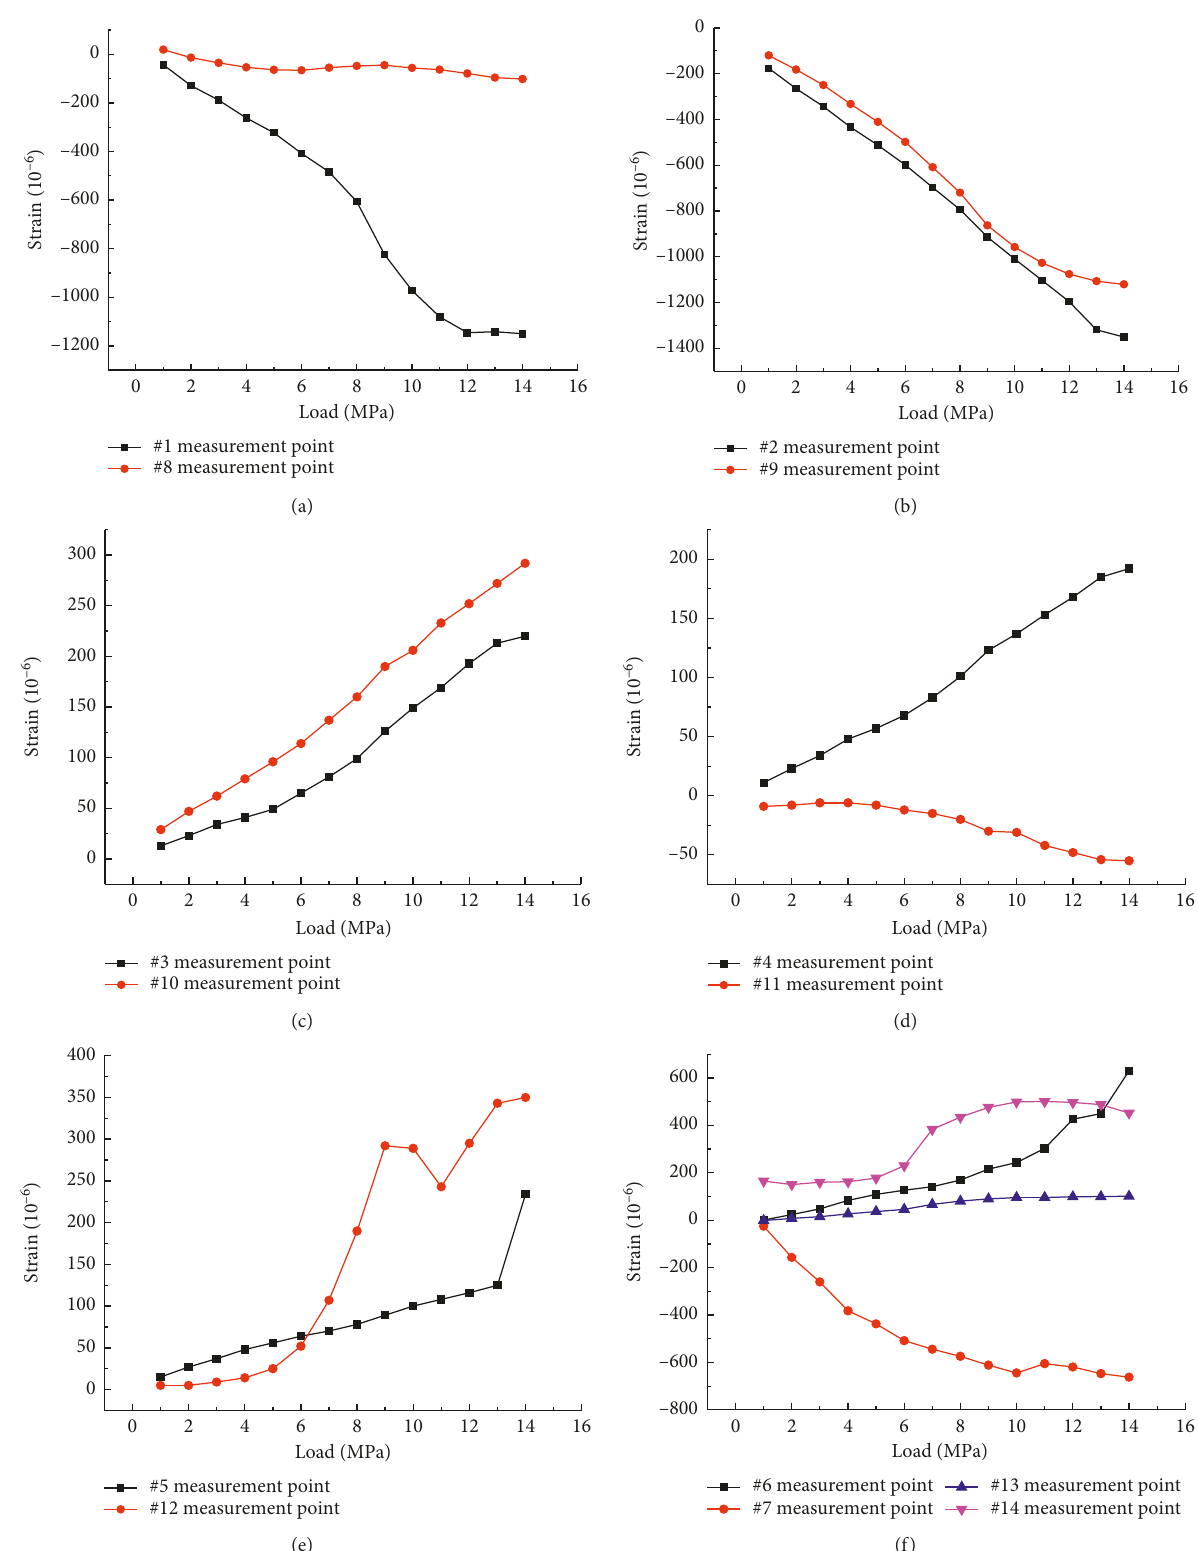
Figure 12: Strain-load curve of the model. (a) Group 1. (b) Group 2. (c) Group 3. (d) Group 4. (e) Group 5. (f) Group